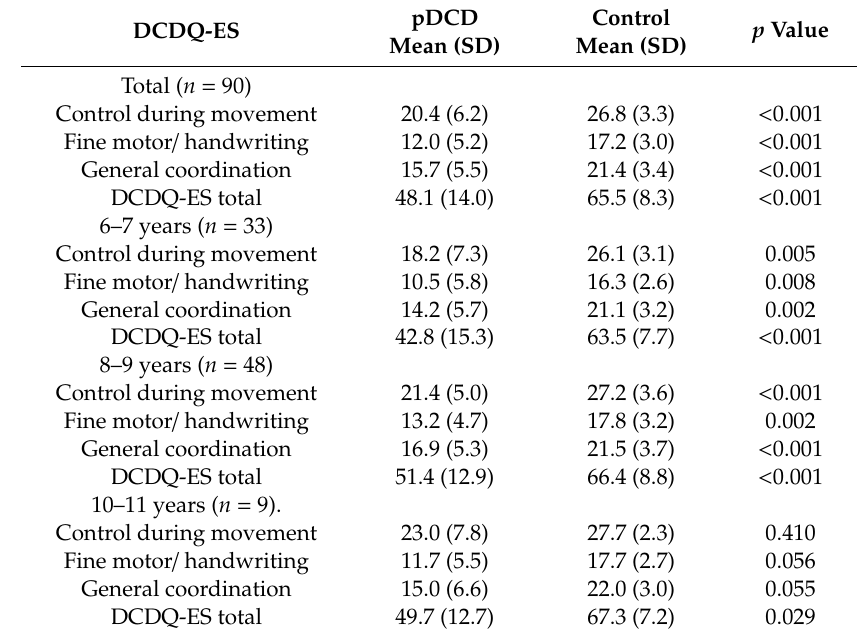
Table 1. DCDQ-ES total and subscale scores for pDCD and matched control group across age groups ( n = 90).